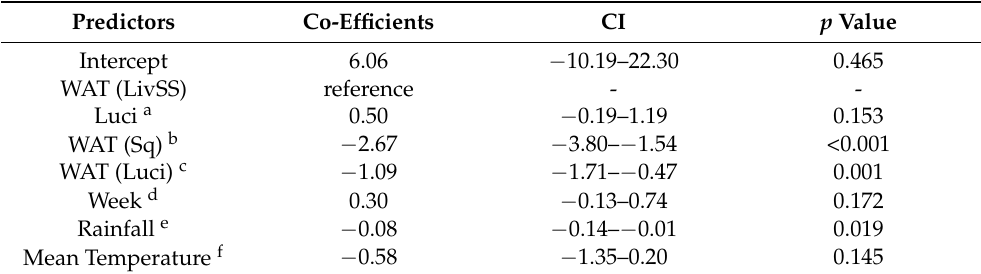
Table 7. Summary of model coefficients, confidence intervals and p values for each predictor of the rate of catch per week of Lucilia sericata . The rate catches per week model included an offset of the bycatch (i.e., all other flies other than L. cuprina and L. sericata ) in each